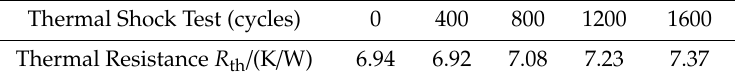
Table 9. The averaged thermal resistances of solder joints vs. ageing cycles.